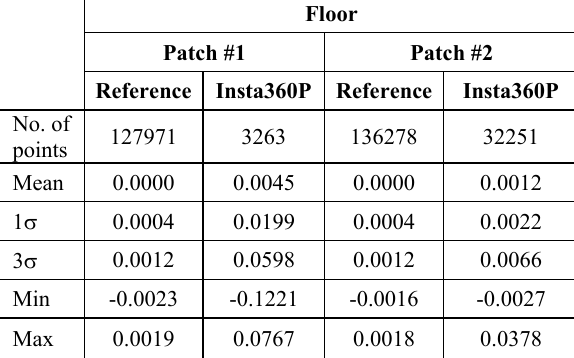
Table 5. Statistical results for surface patches on Floor .